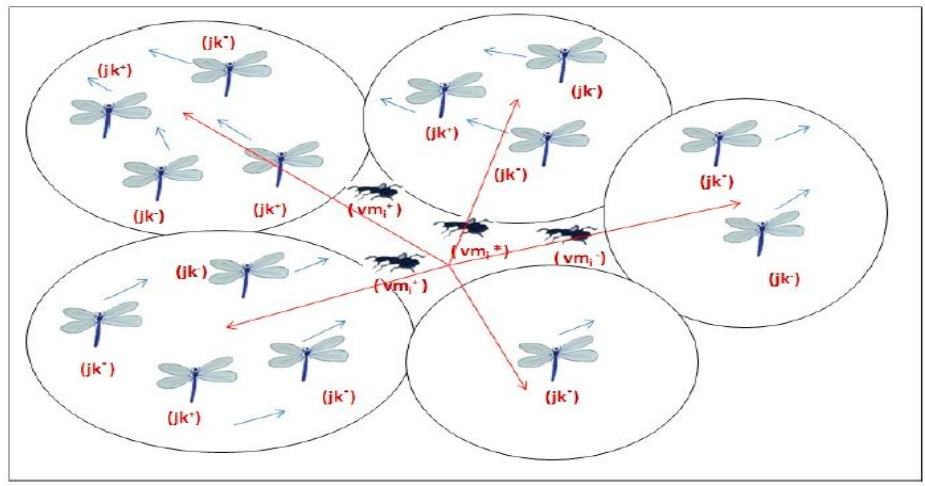
Figure 13. Behavior of dragonfly optimization algorithm [91]. The steps involved are presented in the algorithm. Pseudocode of Standard DAO [104] 1.